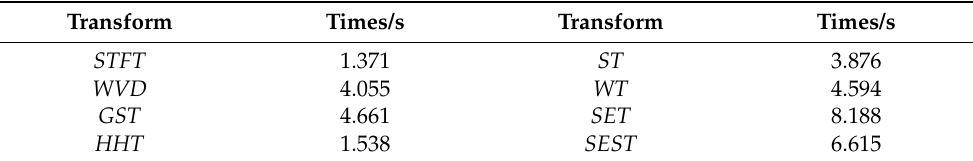
Table 4. Algorithm run times.